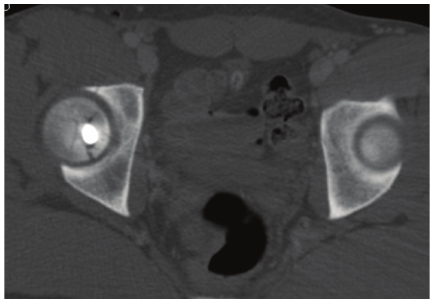
Figure 2: Axial CT scan of the pelvis shows the location of the bullet in the femoral head with accompanying fracture.